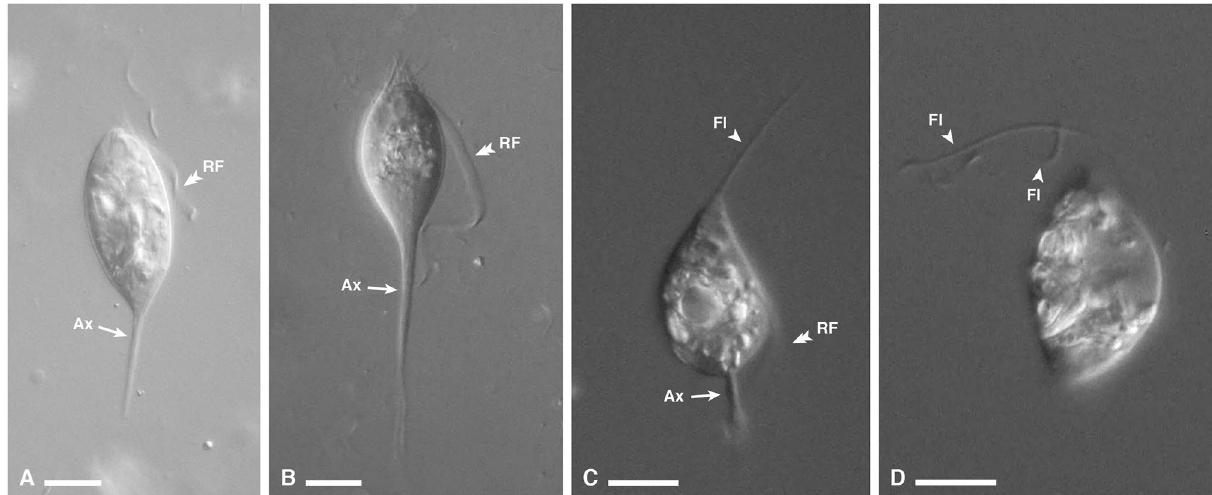
Figure 1. Differential interference contrast light micrographs of Devescovina specimens. ( A , B ) Images of Devescovina sapara from Rugitermes laticollis showing the overall body shape, with the recurrent flagellum and posteriorly protruding axostyle. ( C , D ) Images of Devescovina aymara from Rugitermes sp. showing the overall body shape, flagella, recurrent flagellum, and axostyle. Bars represent 10 μm. RF recurrent flagellum, Ax axostyle, Fl